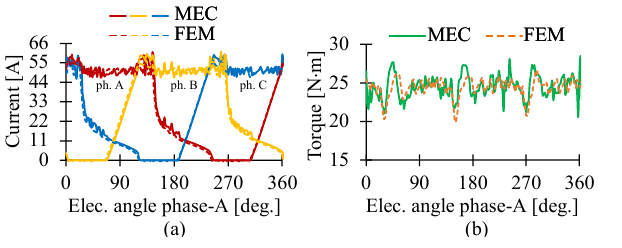
Figure 20. Dynamic characteristics at 4000 r/min at 385 V DC: ( a ) phase currents I ref = 50.5 A, θ ON = − 50 ◦ , and θ OFF = 149 ◦ and ( b ) developed electromagnetic torque.